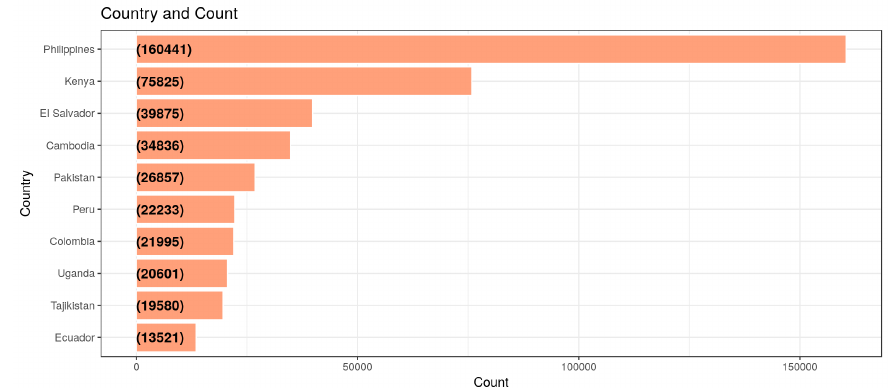
Figure 2. Statistics of loans across different